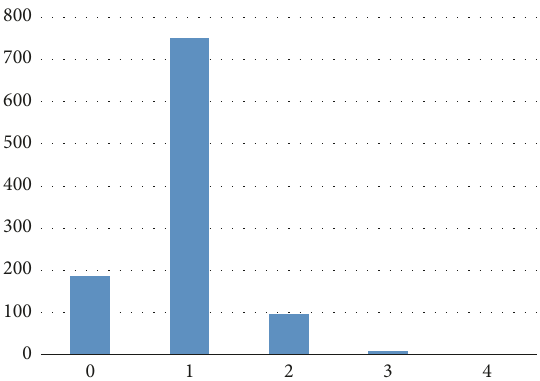
Figure 6: Distribution of number of left-behinds at Dongwuyuan.